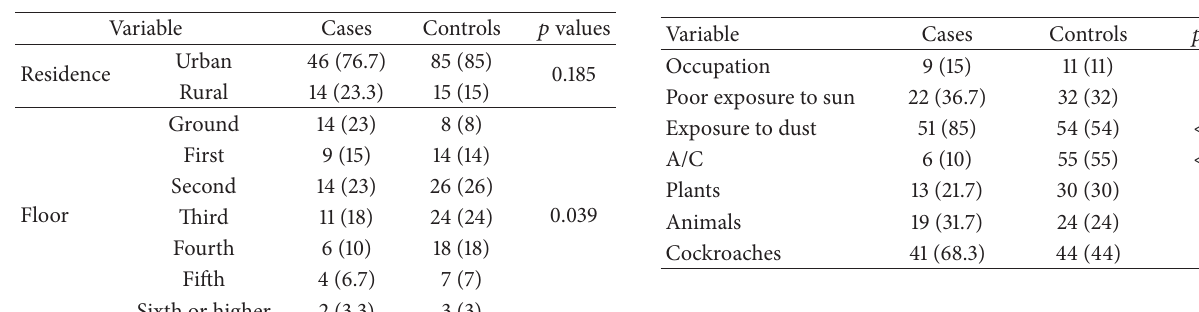
Table 1: Condition of residence in cases and controls.